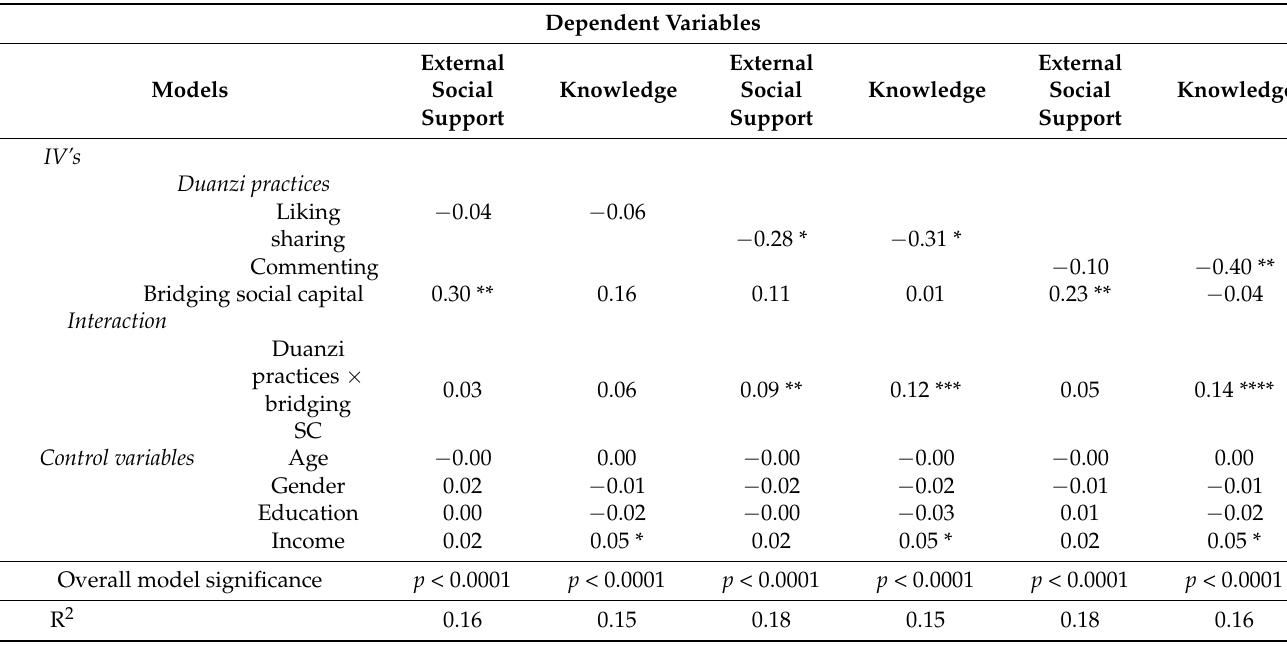
Table 3. Effect of duanzi practices by bridging social